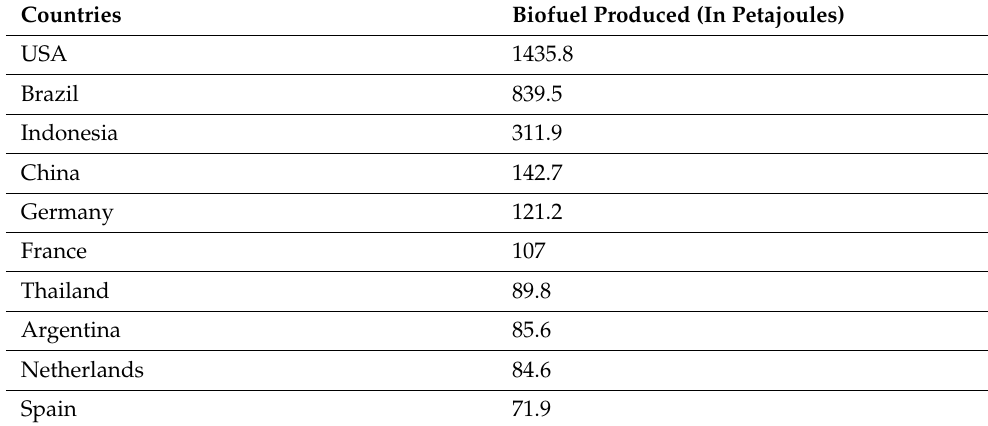
Table 3. List of leading countries producing biofuels globally (2021). Source: Statista Report, 2022 (https://www.statista.com/statistics/274168/biofuel-production-in-leading-countries-in-oil- equivalent/#:~:text=The%20United%20States%20was%20the,840%20and%20312%20petajoules% 2C%20respectively, accessed on 1 September